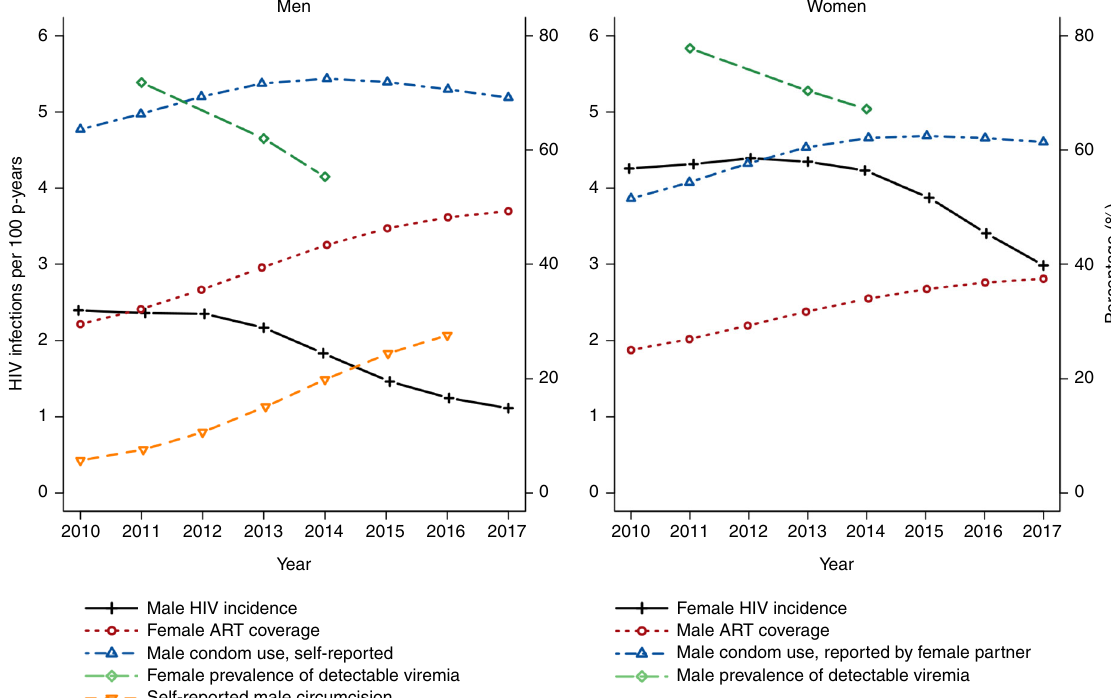
Fig. 3 Trends in HIV incidence, self-reported condom use, self-reported male circumcision, opposite-sex ART coverage, and opposite-sex prevalence of detectable viremia. The fi gure shows that male HIV incidence began to decline after 2012, following increased VMMC coverage, female ART coverage surpassing 35%, and a decrease in the female prevalence of detectable viremia. Declines in female HIV incidence after 2014 correspond with male ART coverage reaching 35% and declines in the male prevalence of detectable viremia.